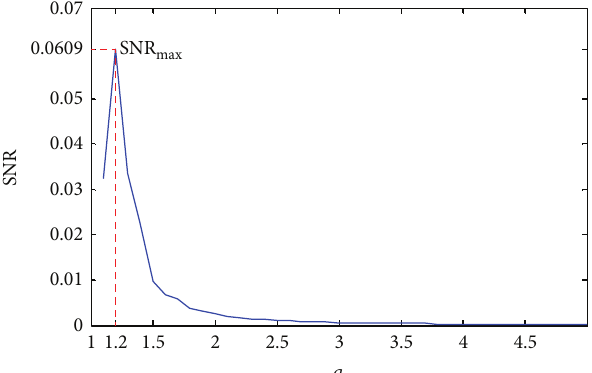
Figure 3: The variation curve of SNR while adjusting the system parameter 𝑎